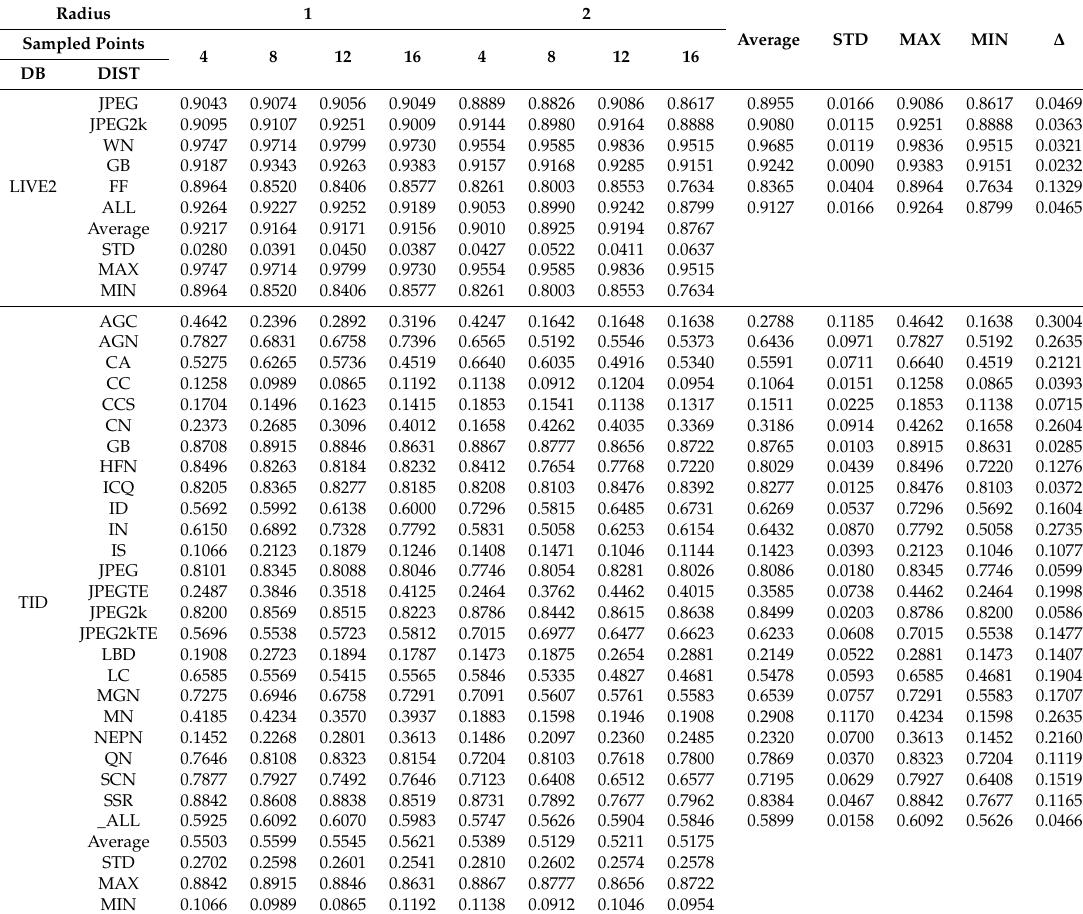
Table 5. Average SROCC of 1000 runs of simulations on tested databases using CLBP